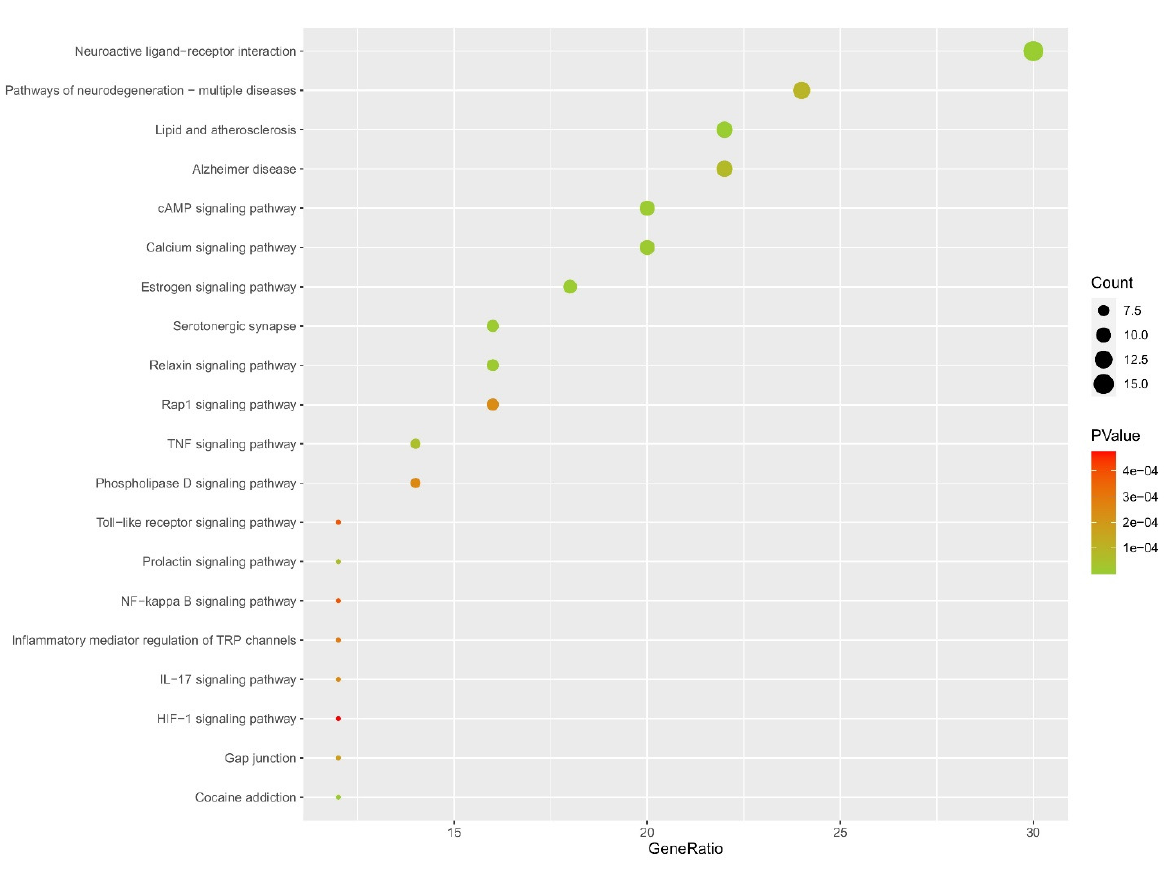
Figure 5. Top 20 KEGG pathways with ranked p value. The y-axis displays the KEGG pathway. The x-axis shows the amount of genes enriched in the pathway. The color represents the p-value, and the size of bubbles represents the amount of targets in the pathway. The color intensity from red to green shows the p value from high to low. The bigger the bubble size, the more targets in the pathway. Table 3. Target genes in the top 20 of KEGG